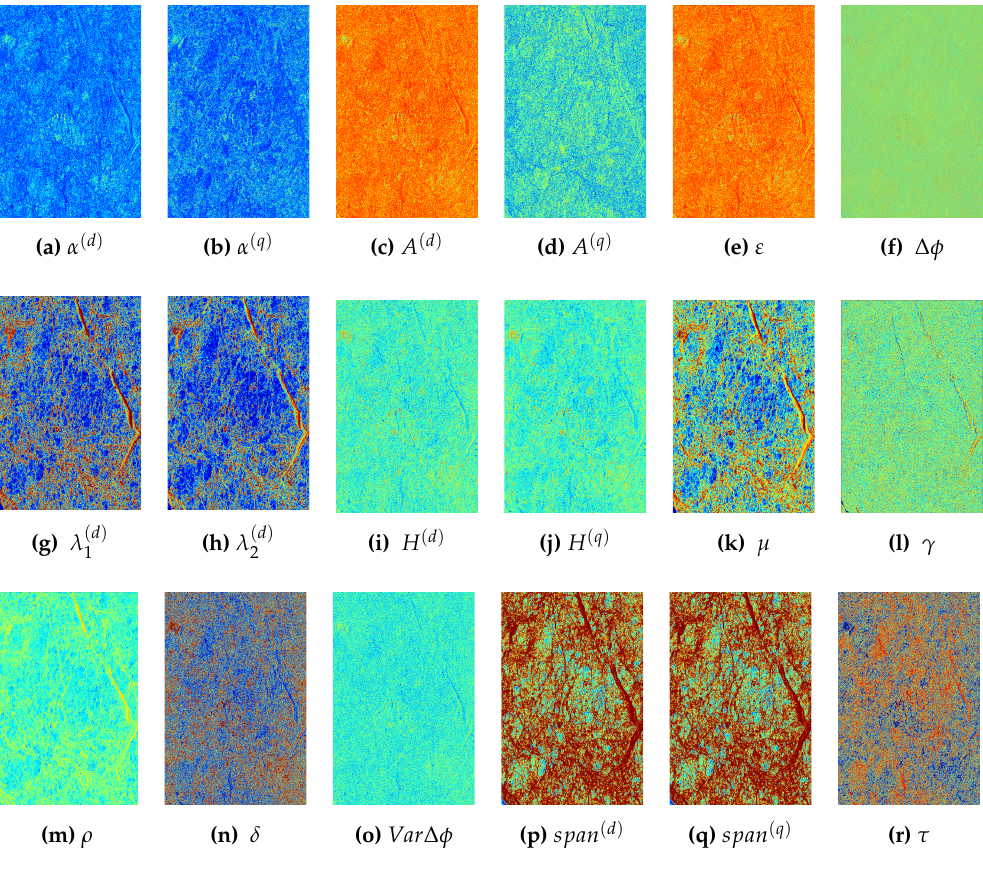
Figure 3. Images of different features for RS-2 23 April 2015, frame 1: ( a ) α ( d ) ; ( b ) α ( q ) ; ( c ) A ( d ) ; ( d ) A ( q ) ; ( e ) ε ; ( f ) ∆ φ ; ( g ) λ ( q ) span ( q ) ; ( r ) τ